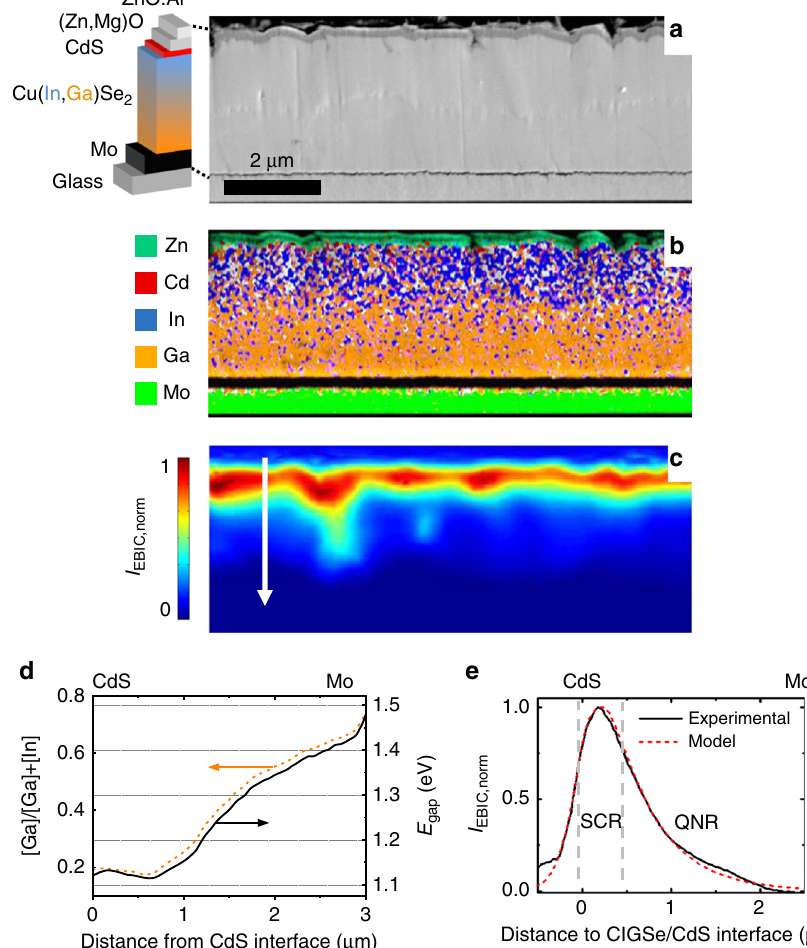
Fig. 2 Electron beam-induced current analysis and energy-dispersive X-ray spectroscopy. a Cross-sectional SEM image, b a corresponding EDX elemental distribution map, and c EBIC image (in which the EBIC values are given by false colors), acquired at the identical position of a ZnO:Al/(Zn,Mg) O/CdS/CIGSe/Mo/glass stack. The EDX map is composed of signals from Ga-L (orange) and In-L X-ray lines (blue) in the CIGSe absorber layer as well as from Zn-L lines (turquoise) in the window layer and also Mo-L lines (green) in the Mo back contact. A weak signal from Cd-L lines (red) is also visible in the buffer layer. d [Ga]/([Ga] + [In]) ratio and corresponding calculated band-gap shift (according to ref. 45 ). e Extracted EBIC pro fi le along the white arrow in c for a beam energy of 12 keV (black solid line) and analytic model (red dashed line). The space-charge (SCR) and quasi-neutral regions (QNR) are highlighted by vertical dashed